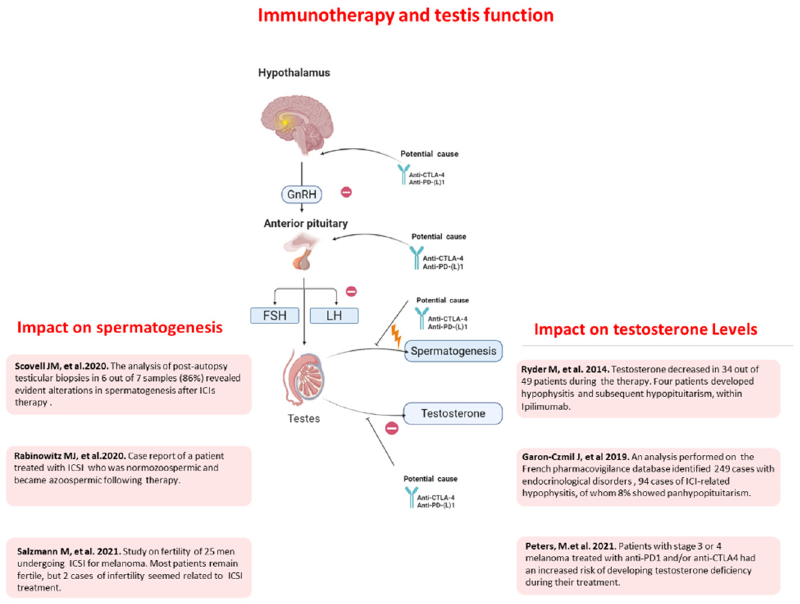
Figure 2. The possible effects direct and indirect of immunotherapy treatment on spermatogenesis and testosterone levels [79,80,82,86,87,89].